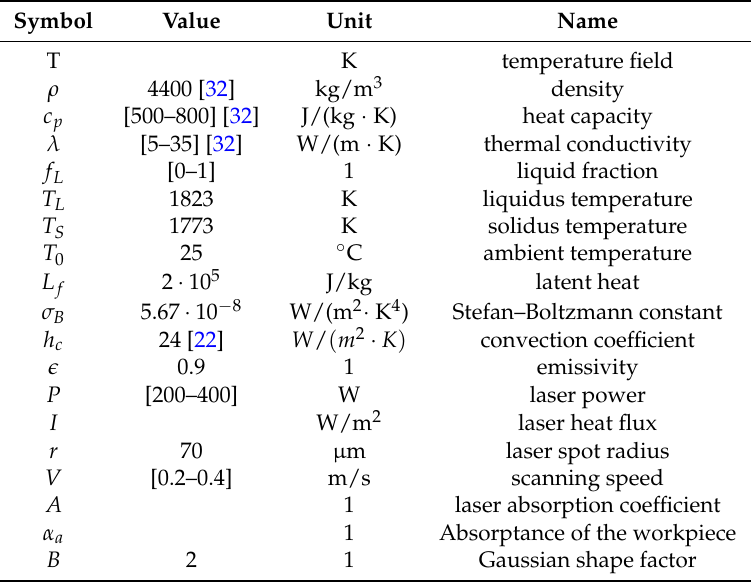
Table 3. Table of the process and material